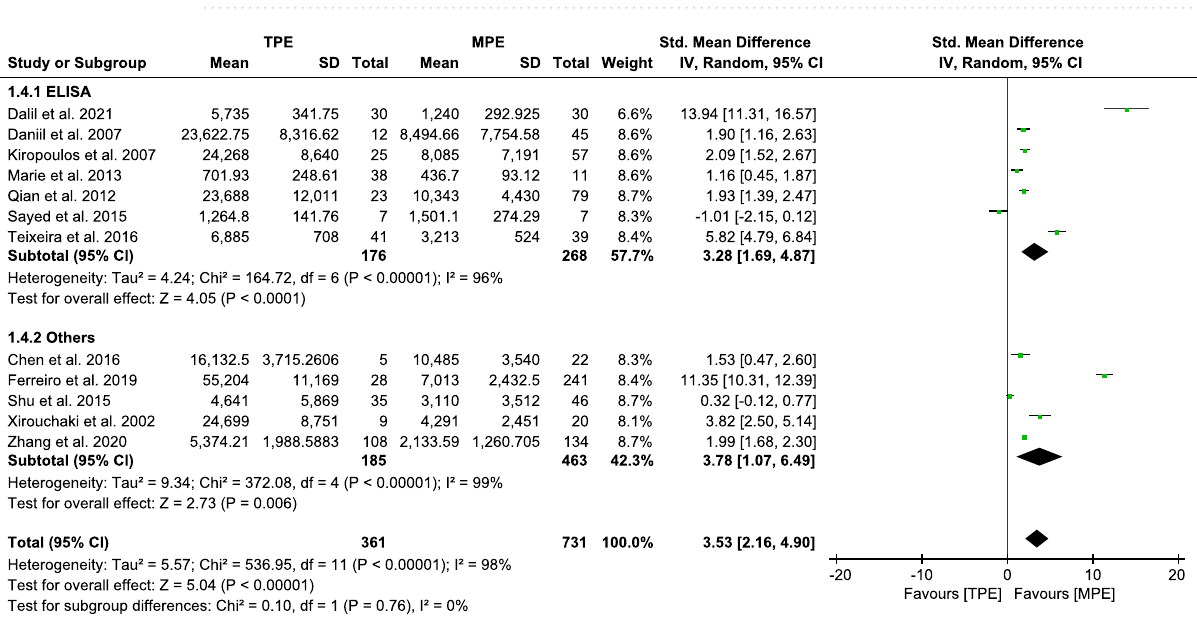
Figure 6. Forest plot of 6 studies comparing IL-10 levels in TPE and MPE subjects. The standardized mean difference (the pleural effusion levels of IL-10 in TPE subjects minus that in MPE subjects) was estimated by meta-analysis.